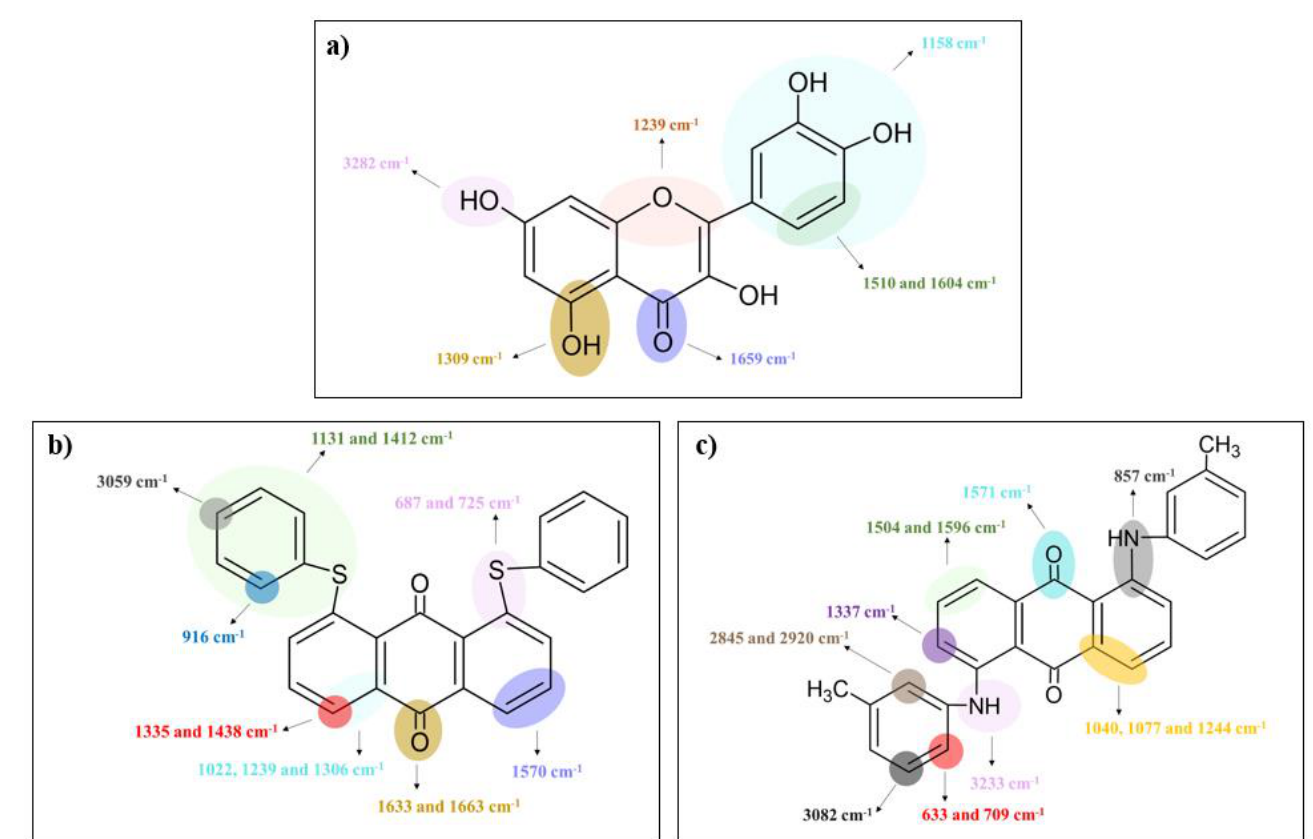
Figure 3. Absorption bands assigned to the chemical groups (bonds) that occur in the powders of ( a ) quercetin, ( b ) C.I. Solvent Yellow 163, and ( c ) C.I. Solvent Red 207.